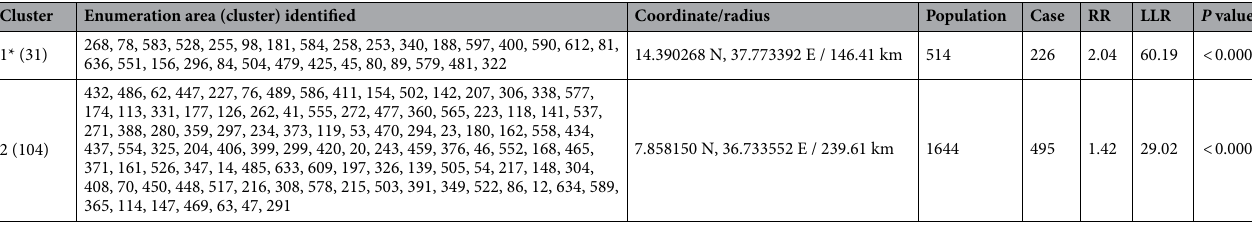
Table 2. SaTScan analysis results of common childhood illness in Ethiopia, 2016. *Primary clusters. LLR Log- likelihood ratio, RR relative risk.